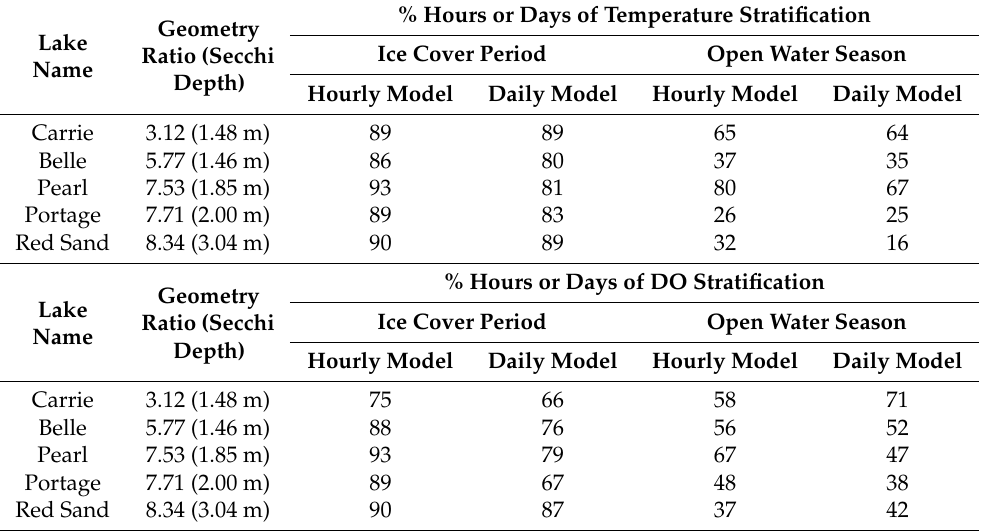
Table 6. Water temperature and dissolved oxygen stratification in study lakes presented as % hours of stratification (hourly model) or % days of stratification (daily model) in